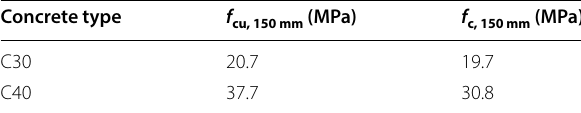
Table 2 Properties of concrete.